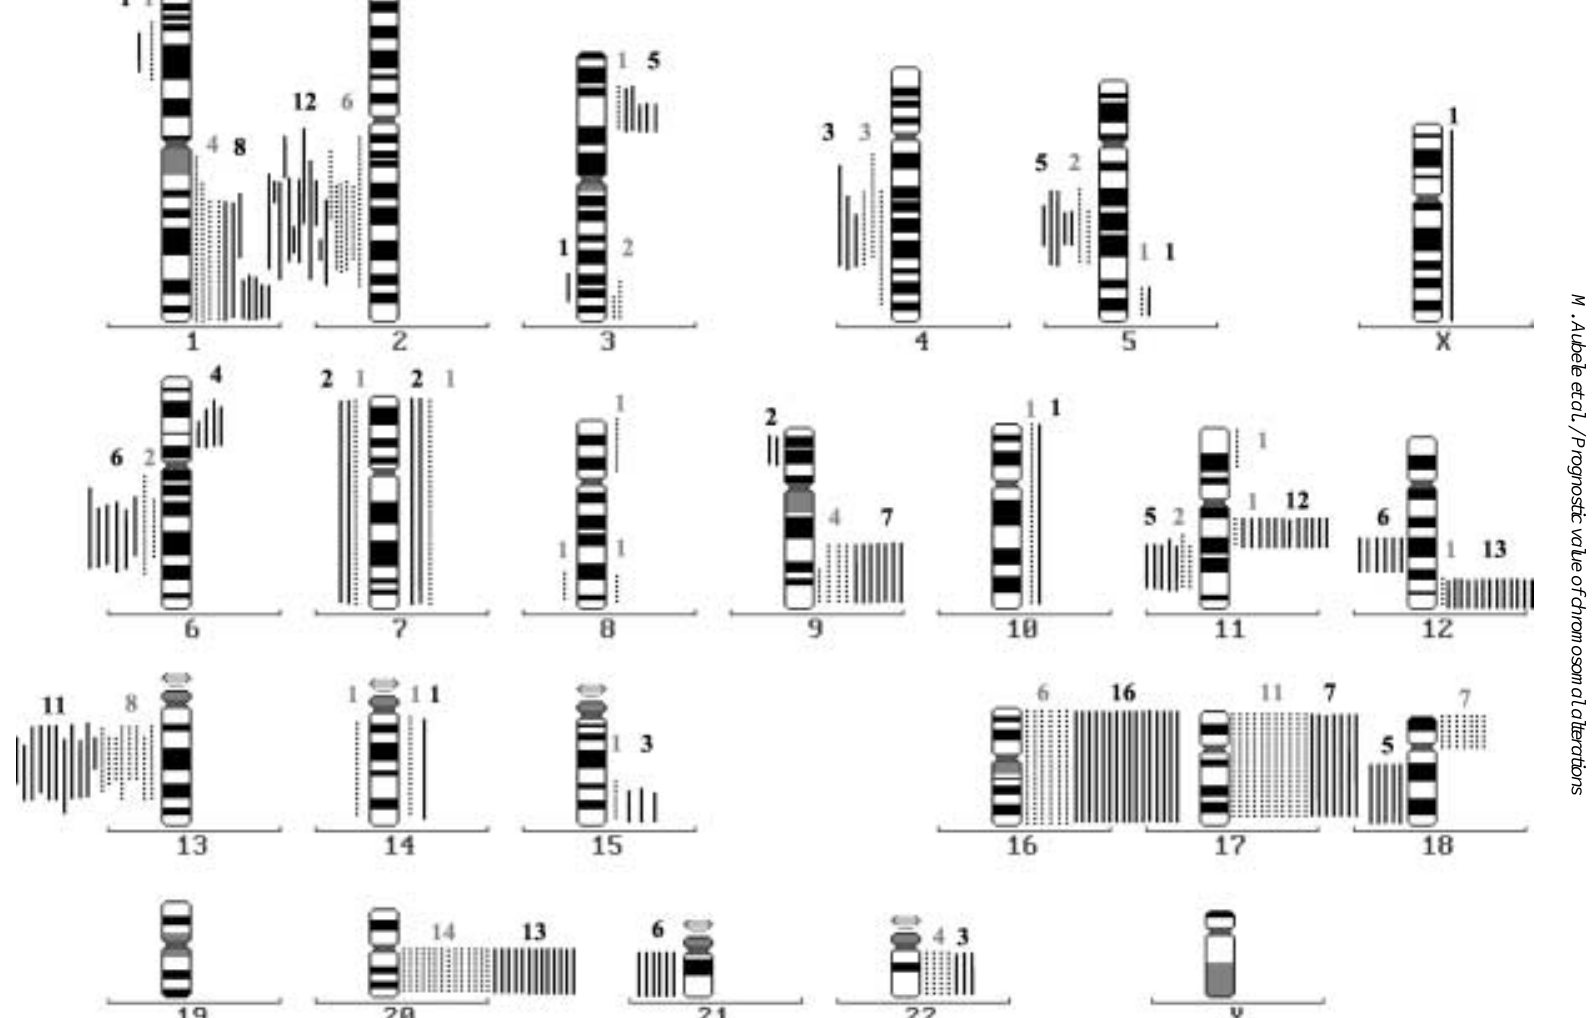
Fig. 1. Ideogram presenting the CGH results from 39 invasive breast carcinomas. Gains are indicated on the right, losses on the left side of the corresponding chromosome. Those alterations identified in tumors building distant metastases during follow-up are plotted in dotted lines, those which are not in solid lines. Additionally the number of cases showing an alteration is